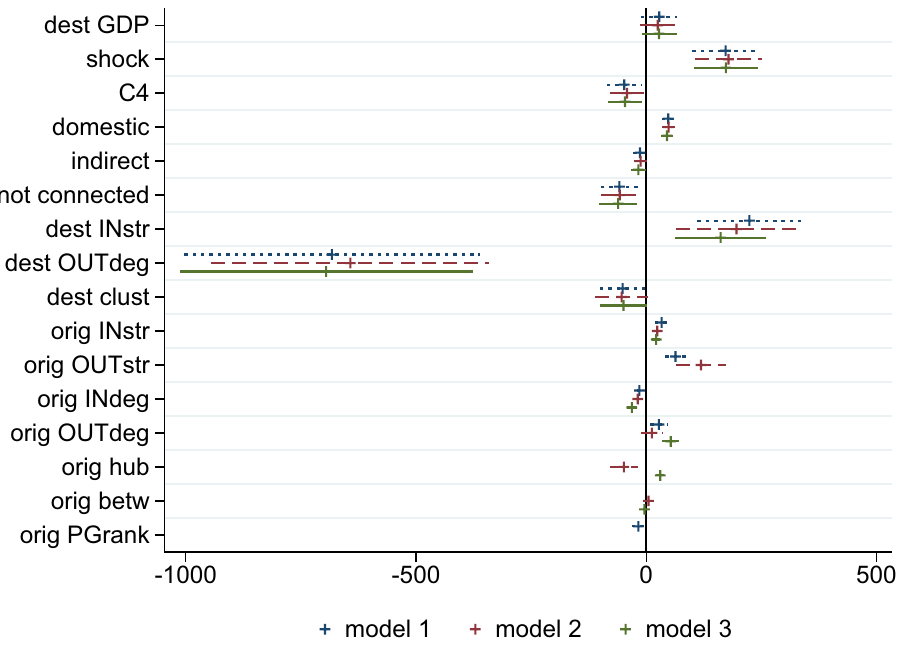
Figure 4. Demand deficit and node characteristics: overview of Tobit regression results. Standardized coefficients from Tobit regression on the determinants of demand deficit. Explanatory variables with non- significant coefficients not reported (full regression results available in Table 5 of “Methods”